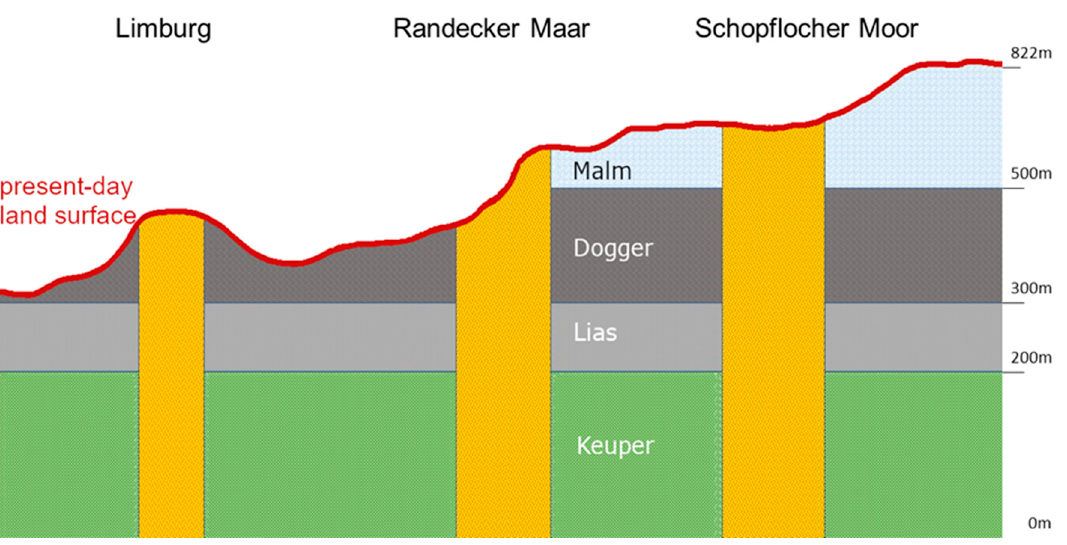
Figure 6. Volcanic vents and erosion (Author’s design, based on [59]).